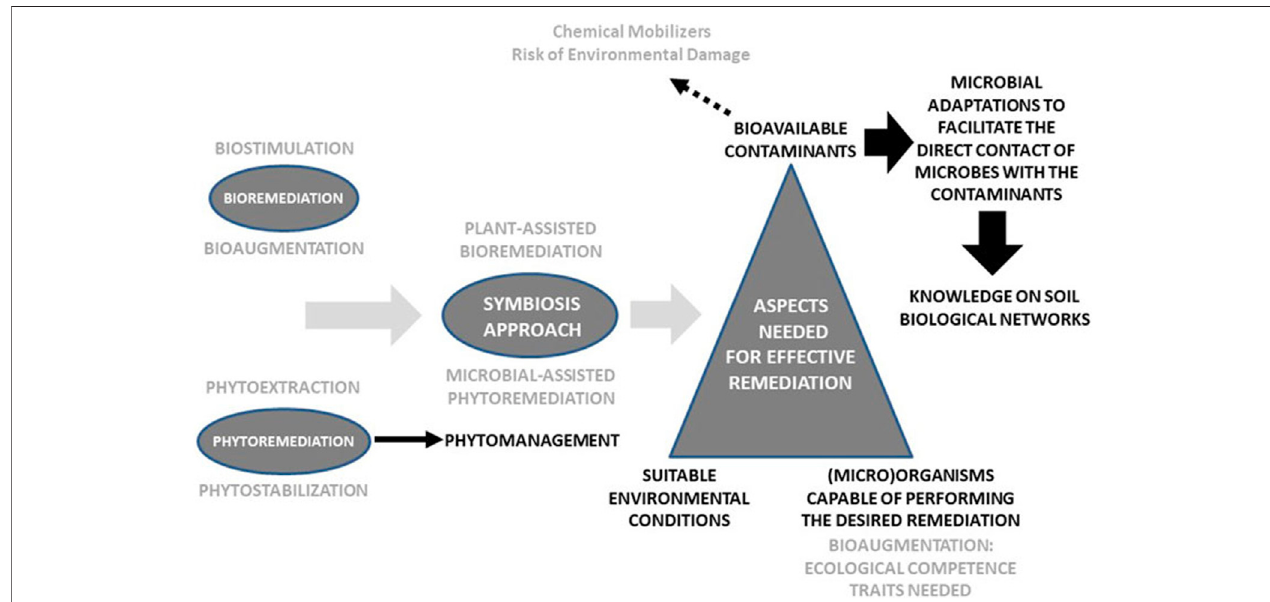
FIGURE 1 | Schematic illustration of the recent integration of two traditionally distinct remediation approaches into a “ symbiotic ” approach, and resulting research needs that have to be addressed in the future (Reprinted from Alkorta and Garbisu).